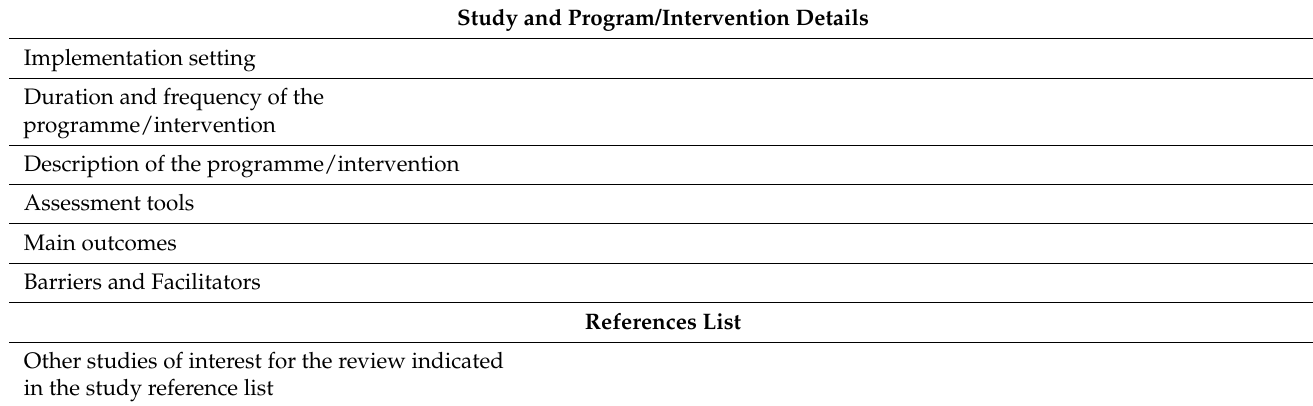
Table A1. Cont. Study and Program/Intervention